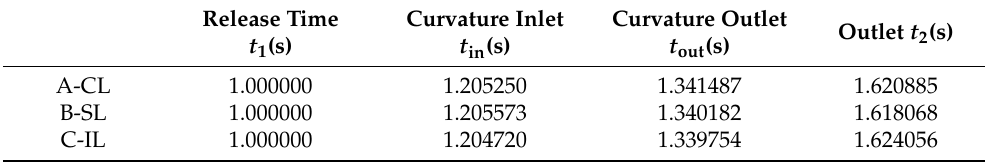
Table 6. Effects of Cr on particle motion time through the whole